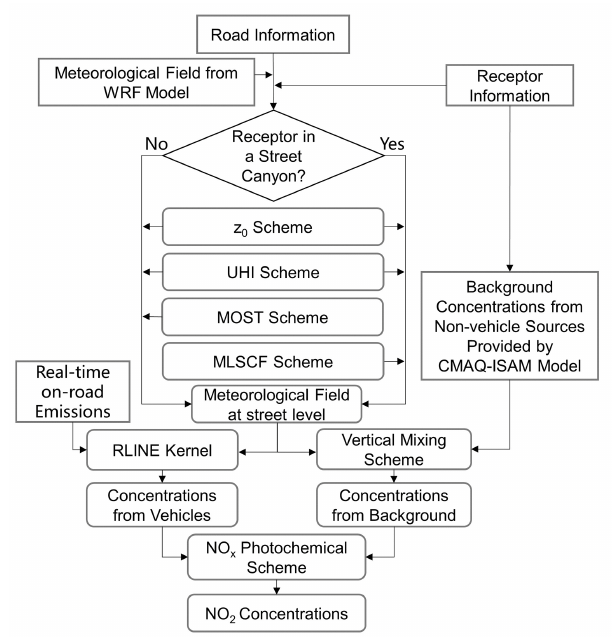
Figure 1. The framework of multiscale hybrid model CMAQ-